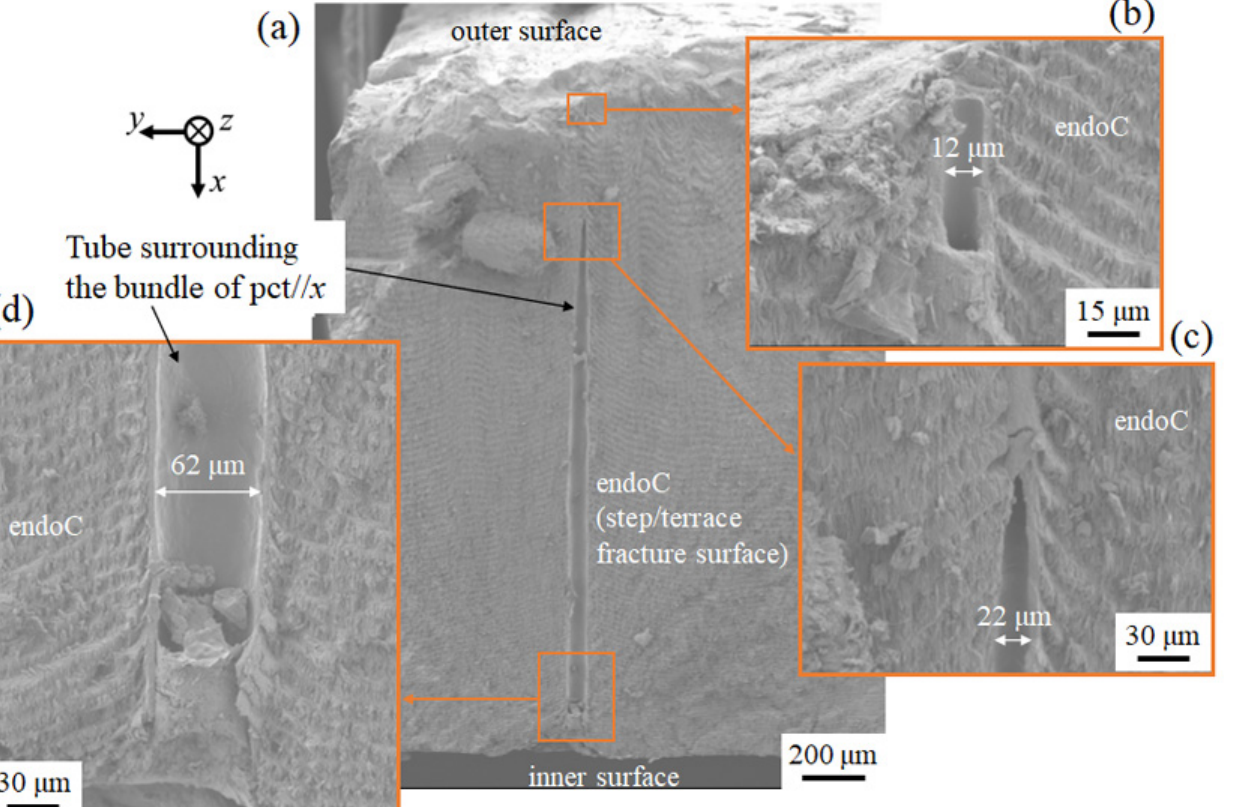
Figure 8. ( a ) SEM images of the fracture surface in the mottled, deep-blue exoskeleton. Enlarged SEM images of the area enclosed by rectangles in ( a ), ( b ) endocuticle near the outer surface, ( c ) endocuticle, and ( d ) endocuticle near the inner surface.